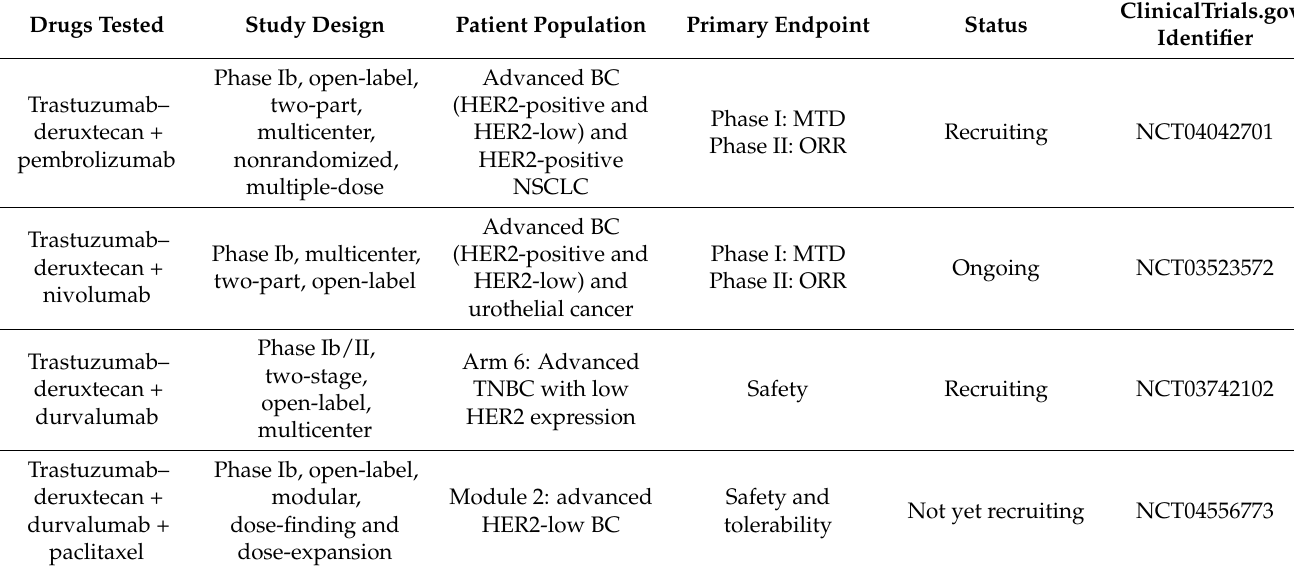
Table 3. Ongoing combinations trials with immune checkpoint inhibitors and the novel anti-HER2 agents in HER2-low breast